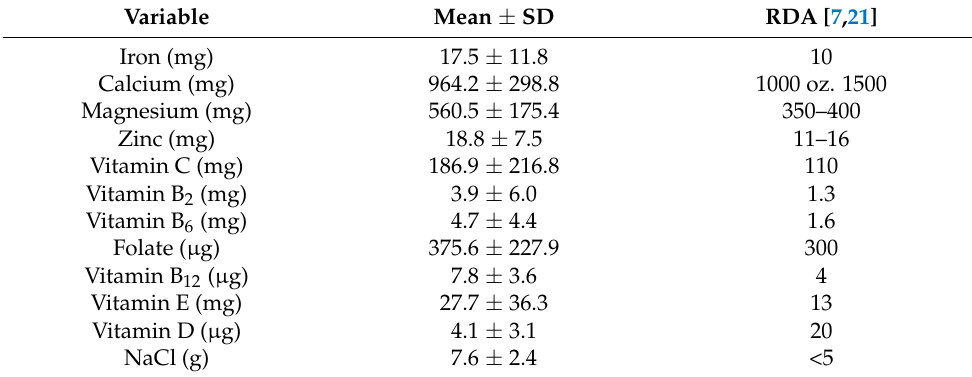
Table 3. Micronutrient intake of subjects.